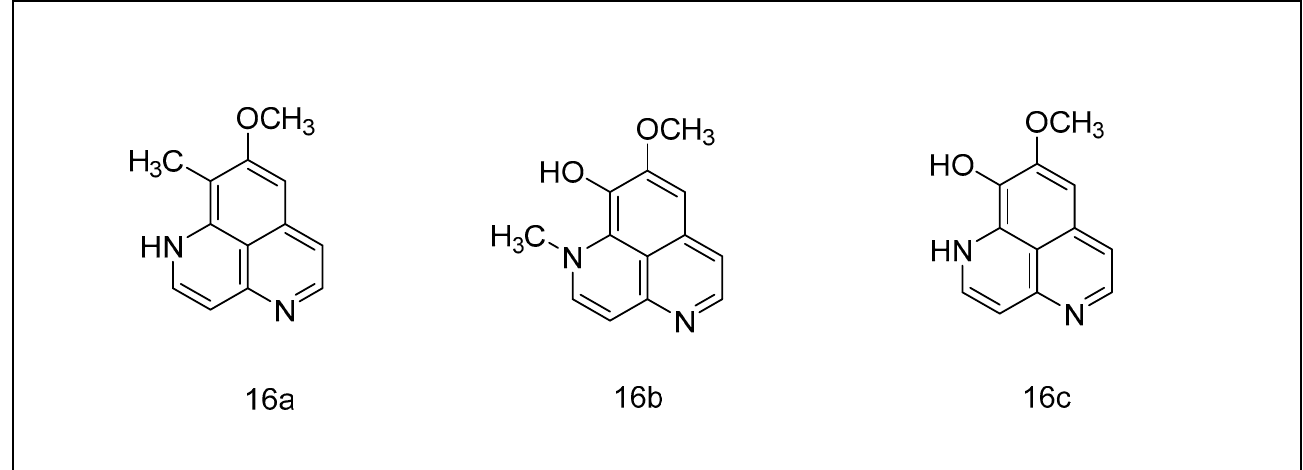
Figure 5. Aaptamine and its derivatives: ( 16a ) aaptamine, ( 16b ) isoaaptamine, ( 16c ) demethylaap-